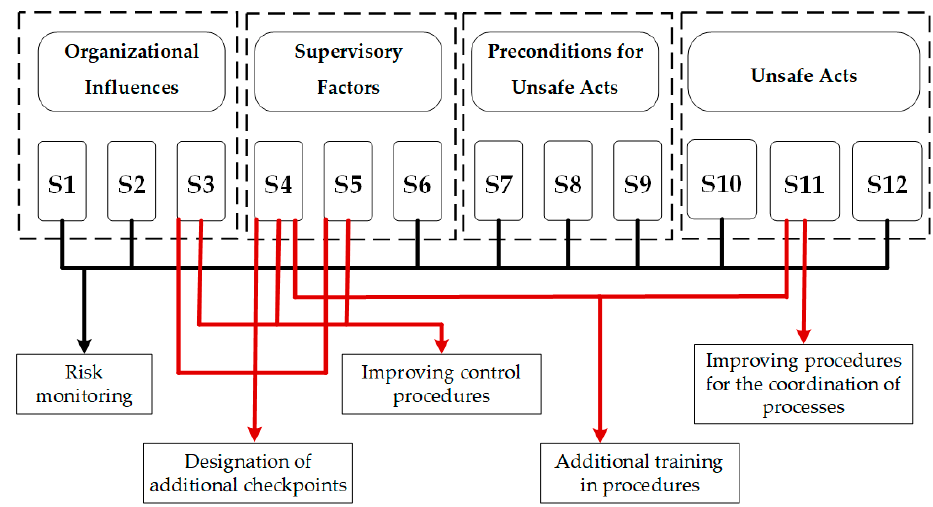
Figure 13. Directions for action for identified risk groups.